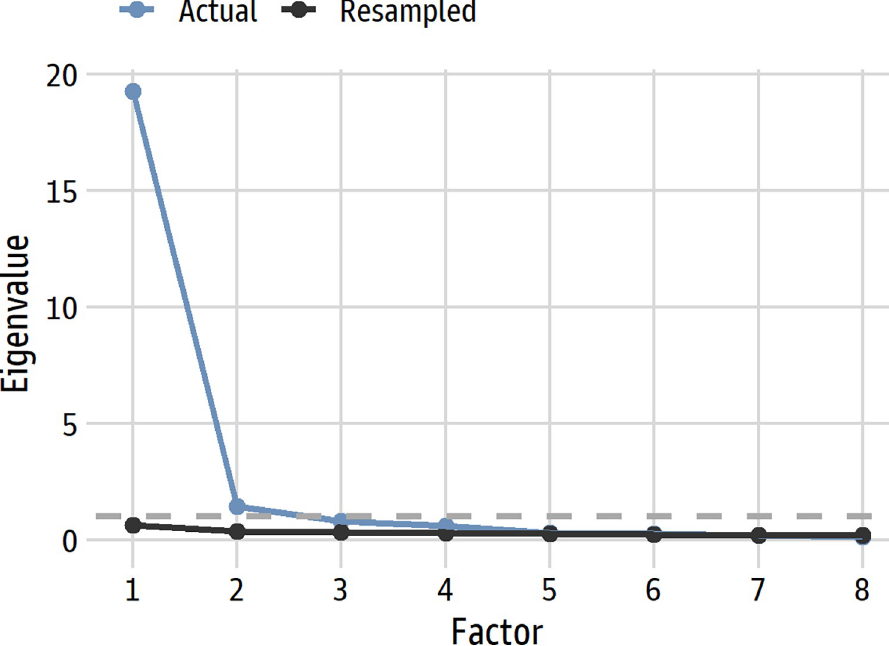
Fig 2. Parallel analysis scree plot for the 36 items. The dashed line denotes an eigenvalue of 1. For clarity, only the first 8 factors are shown. r = 0.10, 0.30, and 0.50 values as benchmarks for small, medium, and large effects) for continu-